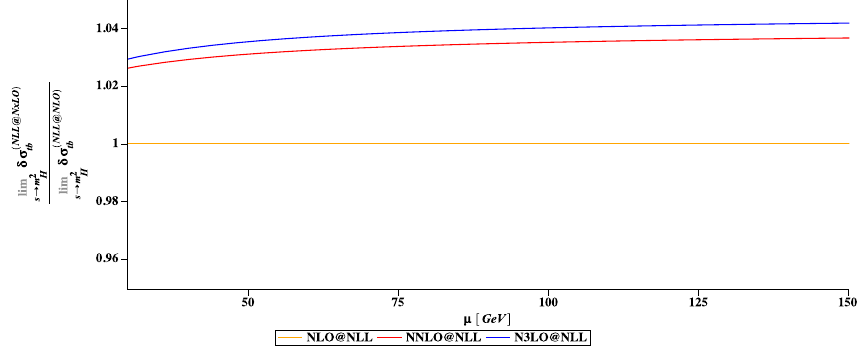
Figure 5 . The scale dependence of the top-bottom interference contribution to the threshold cross section in the NLL approximation. The factorization scale and the renormalization scales of the bottom quark Yukawa coupling and the strong coupling constant are set equal µ f = ν = µ . The bottom quark mass, other than in the Yukawa coupling, is set equal to m b ( m b ). This is a natural choice and differs from the one in table 1 where for purposes of comparison with prior literature we used m b ( µ ) universally.